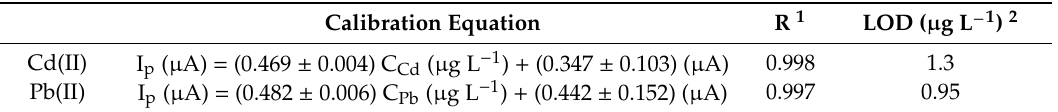
Table 1. Calibration features for Pb(I) and Cd(II).